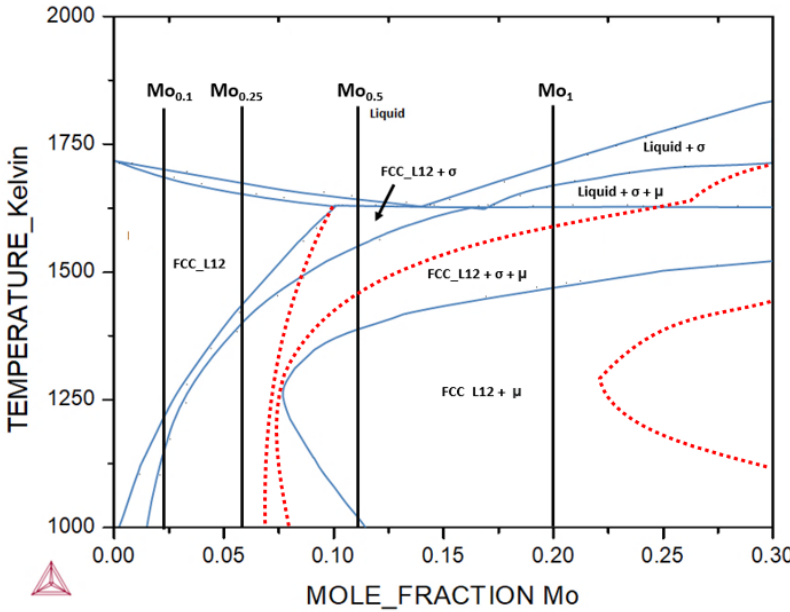
Figure 4. Modified pseudo-binary phase diagram of CoCrFeNi-Mo system.